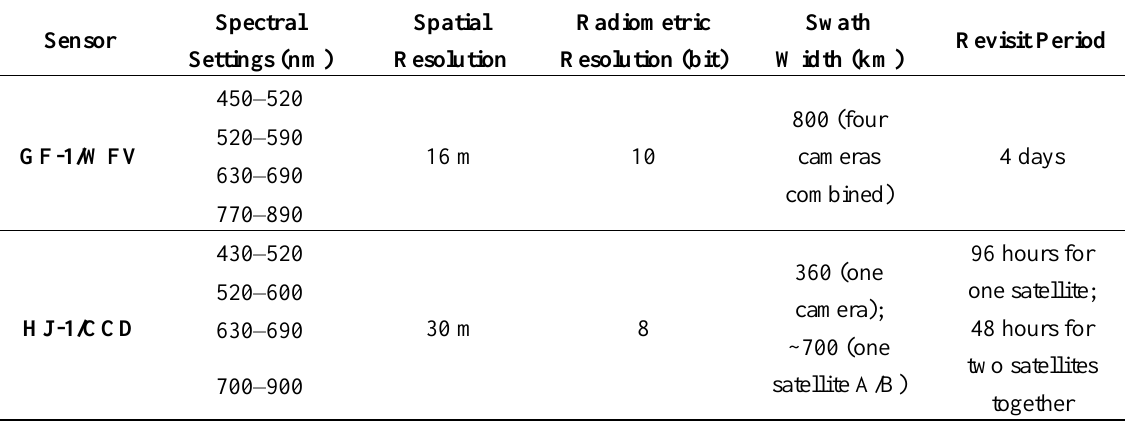
Table 1. Primary characteristics of GF-1/WFV and